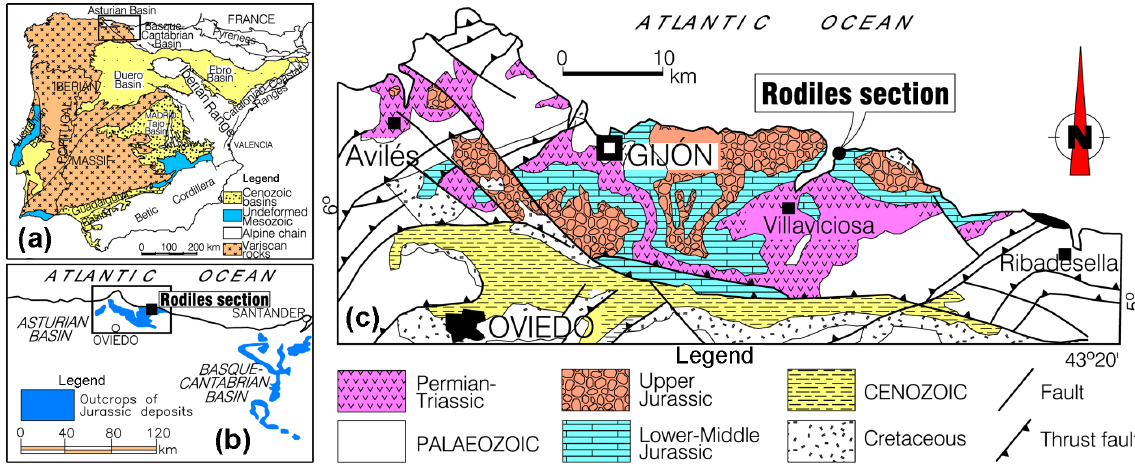
Figure 1. Location maps of the Rodiles section. (a) : sketched geological map of Iberia showing the position of the Asturian Basin. (b) : out- crops of the Jurassic deposits in the Asturian and the western part of the Basque–Cantabrian basins, and the position of the Rodiles section. (c) : geological map of the Asturian Basin showing the distribution of the different geological units and the location of the Rodiles